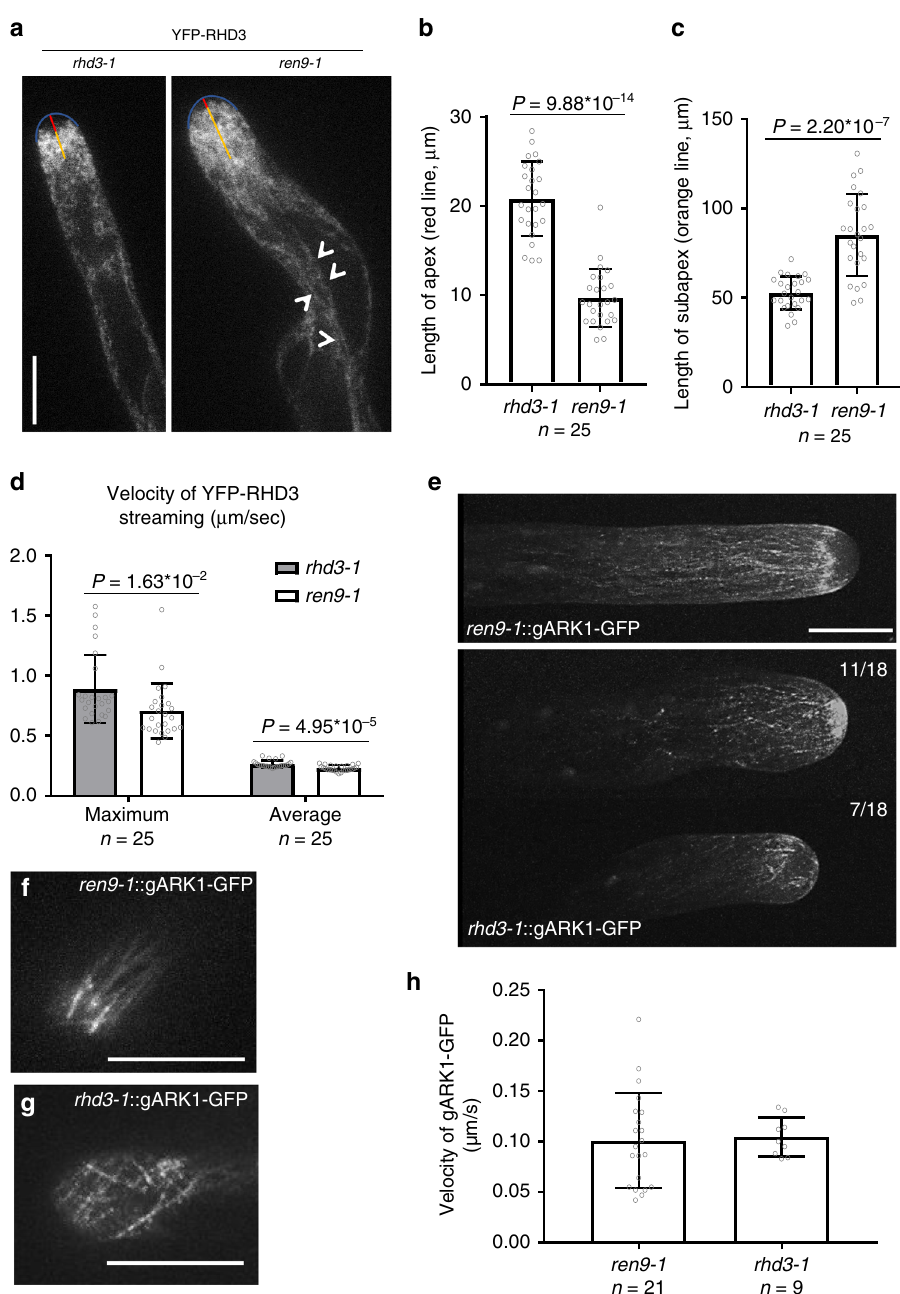
Fig. 7 ARK1 and RHD3 are functionally interdependent. a Distribution of YFP-RHD3 in rhd3-1 and ren9-1 . b , c Quanti fi cation of the length of the apical dome ( b ) and the subapical region ( c ) of rhd3-1 and ren9-1 expressing YFP-RHD3. Columns = mean values, error bars = standard deviations. Gray circles represent actual data. P values indicated for signi fi cances between samples are calculated by Student ’ s t test (two-sided). n = individual root hairs. d Maximal and average velocity of RHD3 streaming in growing root hairs of rhd3-1 and ren9-1 expressing YFP-RHD3. Columns = mean values, error bars = standard deviations. Gray circles represent actual data. P values indicated for signi fi cances between samples are calculated by Student ’ s t test (two-sided). n = individual root hairs. e Distribution of gARK1 – GFP in root hairs of rescued ren9-1 (upper panel) and rhd3-1 (lower panel). Z-projection images are shown. The ratio of the representative gARK1 – GFP distribution in rhd3-1 is indicated at the upper right corners. f , g Time-projection of gARK1 – GFP punctae in the cortex of a growing root hair of ren9-1 ( f ) and rhd3-1 ( g ). A total of 21 images were captured with an interval of 2 s. Scale bars = 10 µ m. h Velocity of gARK1 – GFP punctae in growing root hairs of ren9-1 and rhd3-1 . gARK1 – GFP was imaged every 2 s. Columns = mean values, error bars = standard deviations. Gray circles represent actual data. n = individual gARK1 – GFP punctae/comets. Source Data are